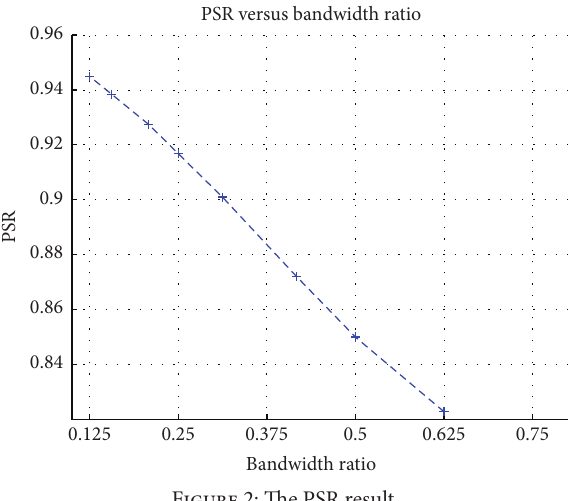
Figure 2: The PSR